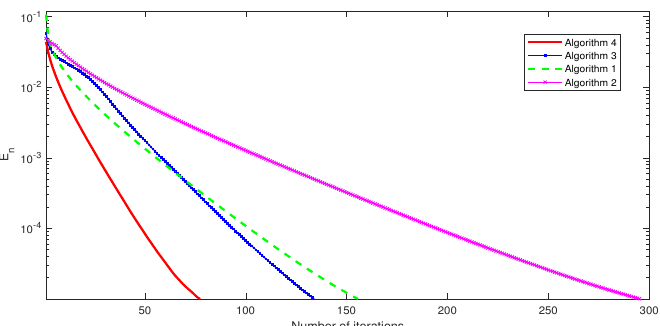
Figure 2. MSE versus number of iterations when N = 1024, M = 512 and κ = 10 − 5 .